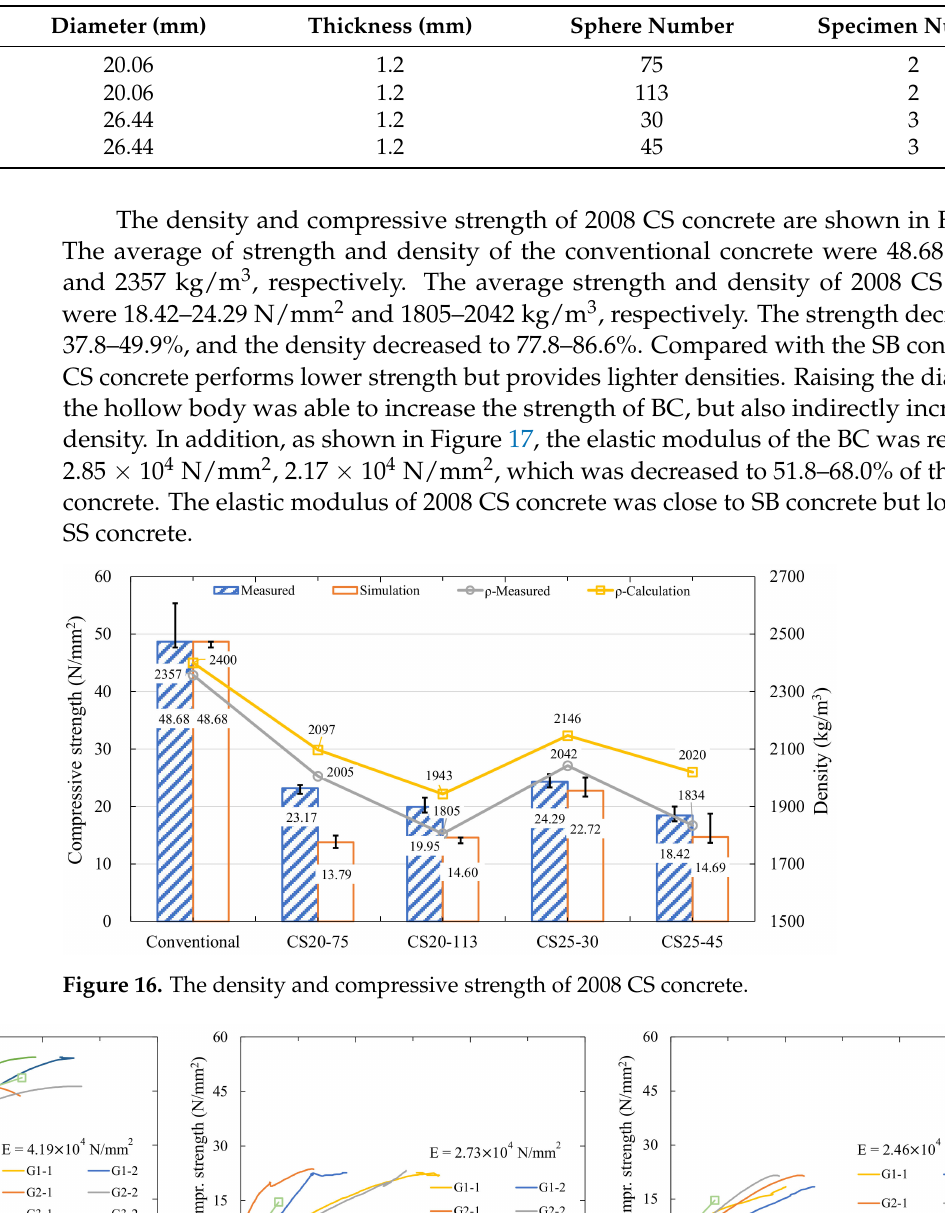
Table 3. The sphere diameters and the number of spheres mixed.